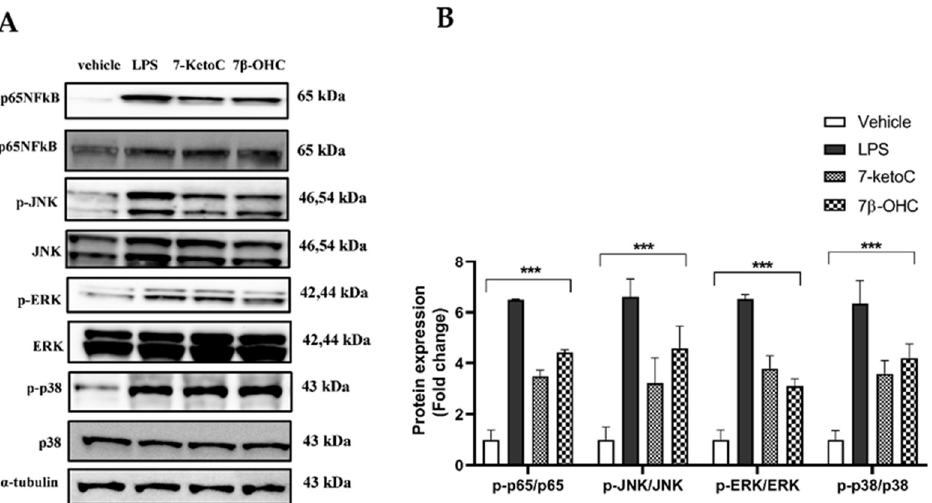
Figure 1. TLR-4 signaling is enhanced in fpEC upon exposure to oxysterols. ( A ) Representative western blot showing phosphorylation of MAPK (p38, JNK, ERK) proteins and NFκB (p65 subunit) in fpEC treated with 7-ketoC or 7β-OHC. LPS (100 ng/µL) treated cells served as the positive control. ( B ) Quantitative analysis of immunoblots (oxysterol-treated cells relative to vehicle control; n = 6). Data are presented as mean ± SEM. Statistically significant differences between vehicle and treatments were calculated using two-way ANOVA, followed by Dunnett’s post hoc test. *** p < 0.001.